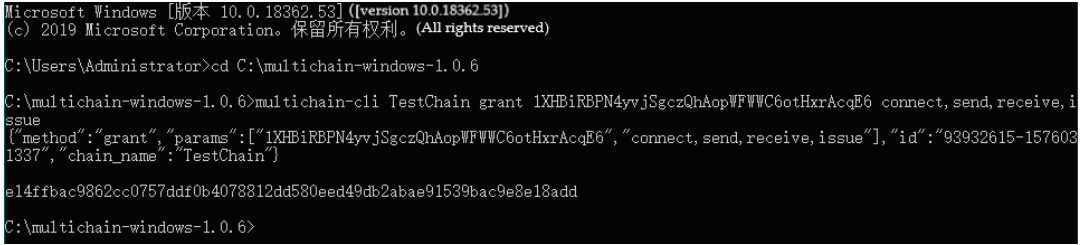
Figure A4. Master-slave node connection diagram. Appendix C.2. Chain35kV’s Scheduling Data Upload and Chain11kV Receiving